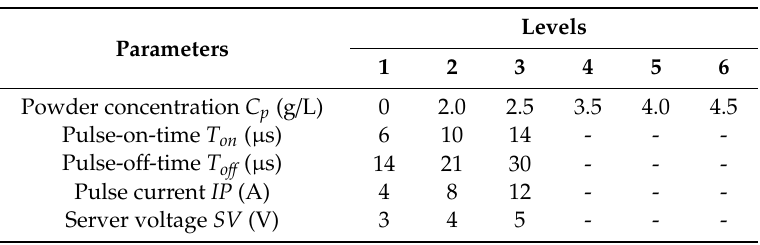
Table 2. The PMEDM parameters with levels.